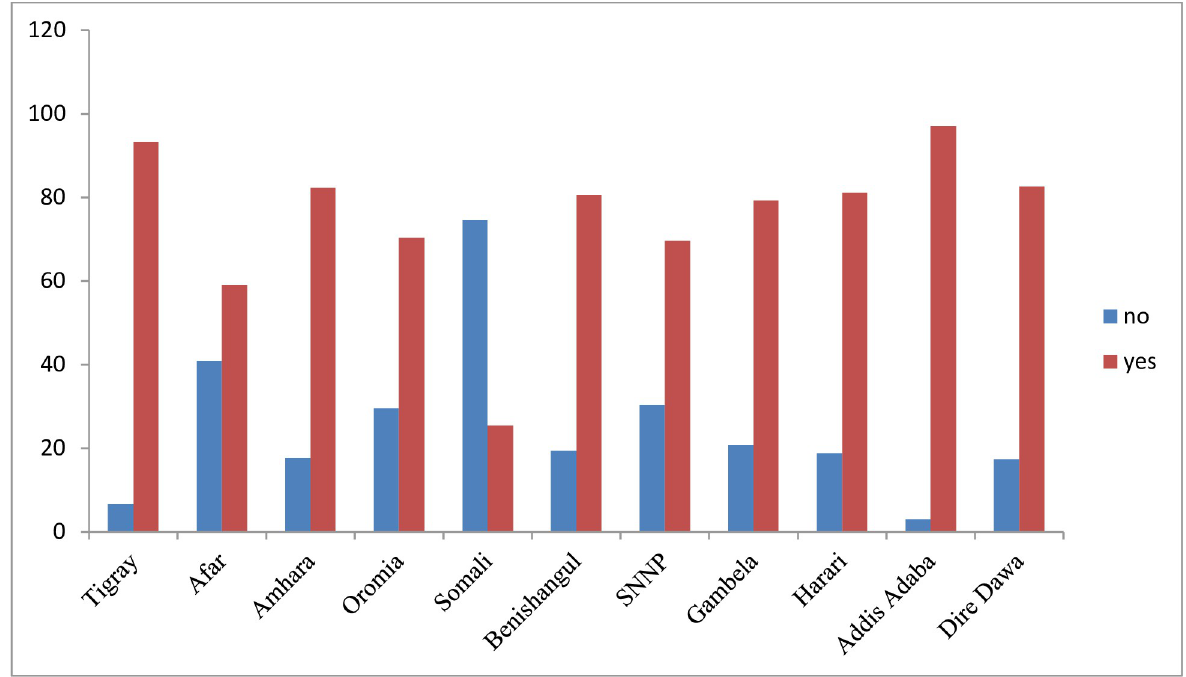
Fig 1. Regional disparities of ANC services utilization among women in Ethiopia, 2019.